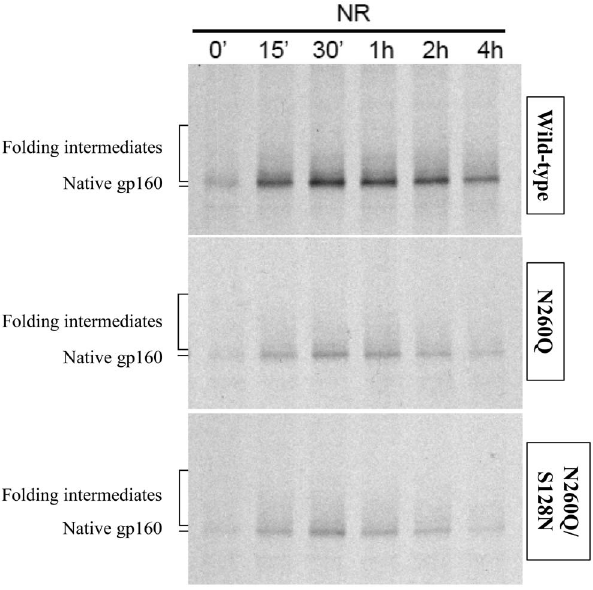
Figure 7. Immunoprecipitation of WT and mutant gp160 with CD4-IgG2. Aliquots of detergent lysates from Figure 6 were used for gp160 pull-down with CD4-IgG2, deglycosylation and subjection to SDS-PAGE. Films were exposed for 1 month.